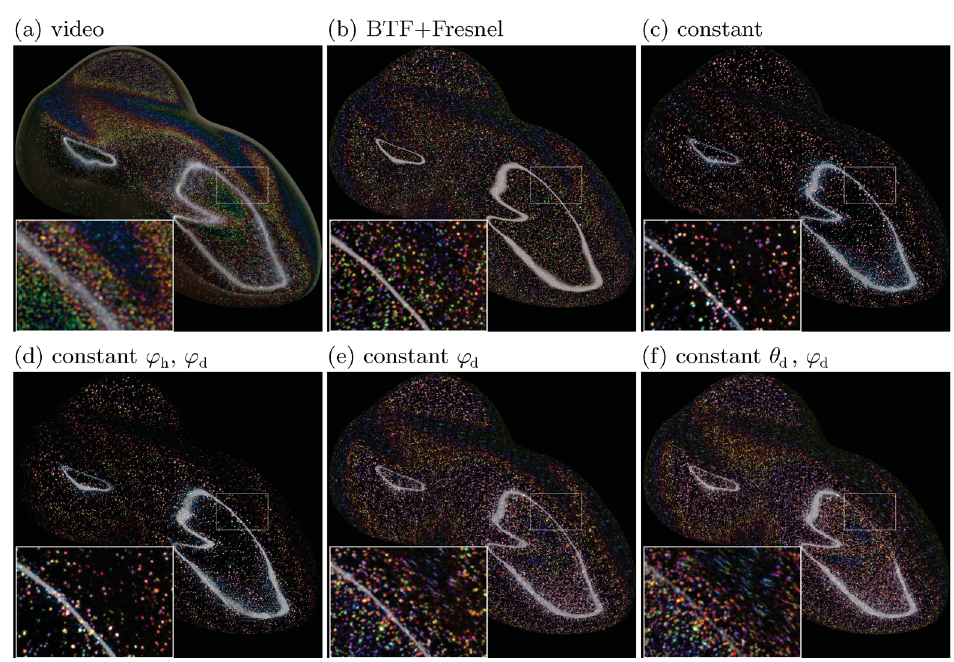
Fig. 12 Comparison of original flake dynamics to those from the tested representations. Colors represent per-pixel differences computed across 720 frames varying point-light position over the object.